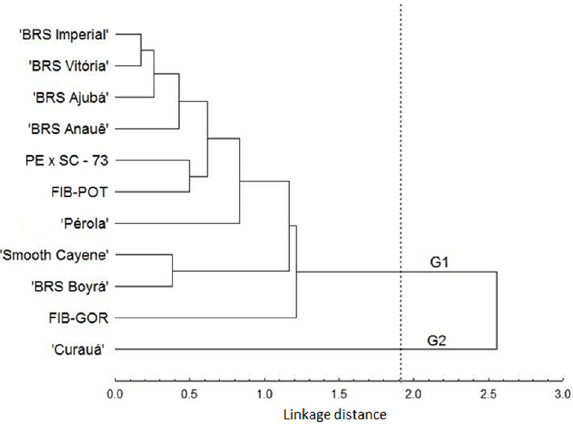
Figure 3 - Dendrogram of the 11 pineapple genotypes based on the mean Euclidean distance and the fiber quality variables. The UPGMA method was used to define the groups and cutoff point was defined according to the parameters indicated by Mingoti